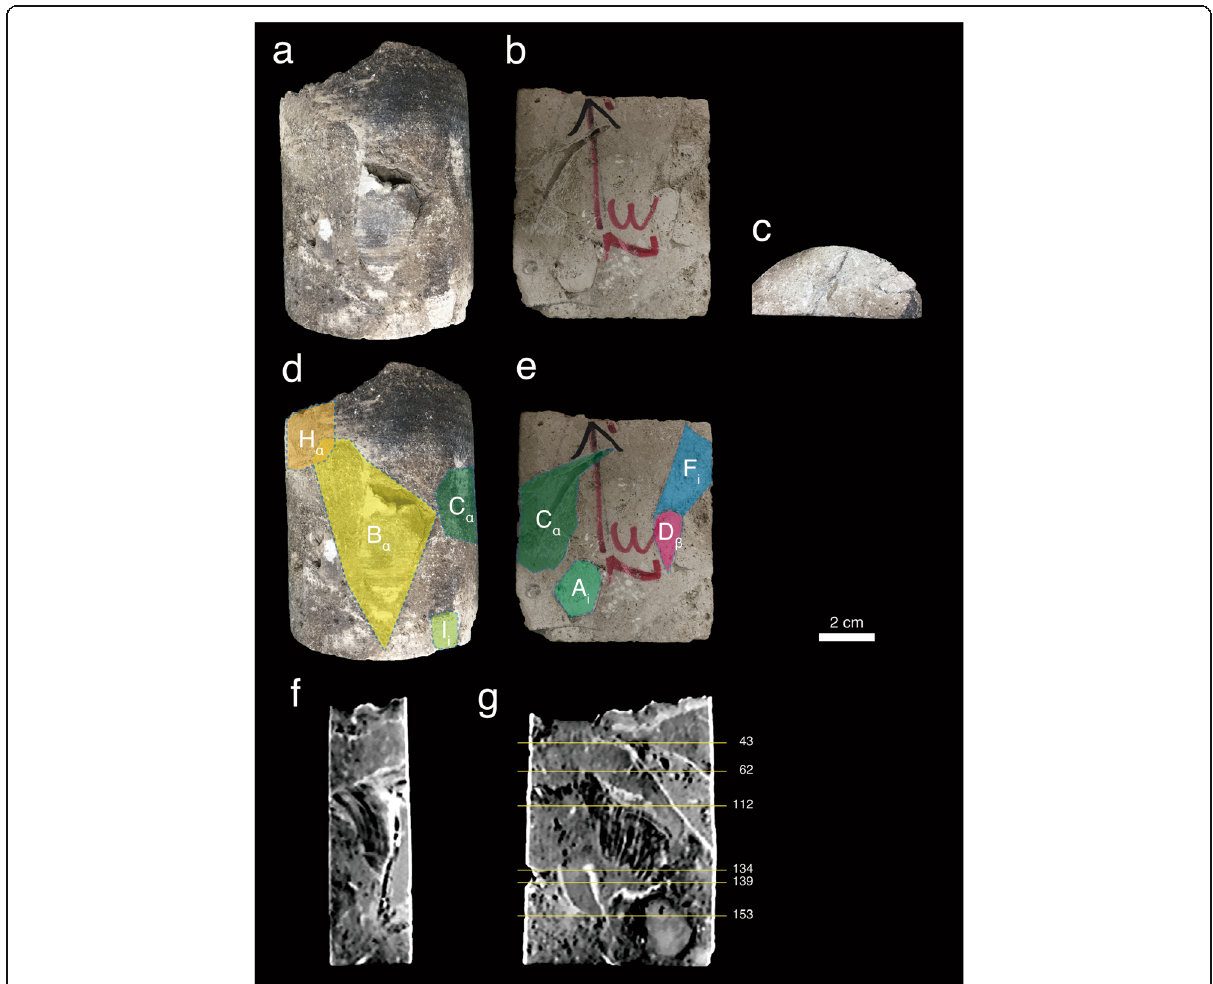
Fig. 2 Core photographs and X-ray CT images. a – e External appearance of the core. Note that rudists A – D, F, H. and I are indicated. a , d Side view of the external core surface. b , e Side view of the split core surface. c Top view. f , g Vertical slice images of the core obtained by X-ray CT. f Side view. g Side view of the core at ~ 0.5 cm from the external surface. Horizontal slice images of the numbered horizons (43, 62, 112, 134, 139, and 153) are shown in Fig. 4. α , Radiolitidae α with a thick outer layer; β , Radiolitidae β with a thin outer shell layer; i,